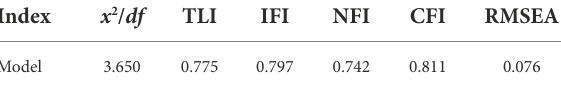
TABLE 6 Intermediate model fitting index (before